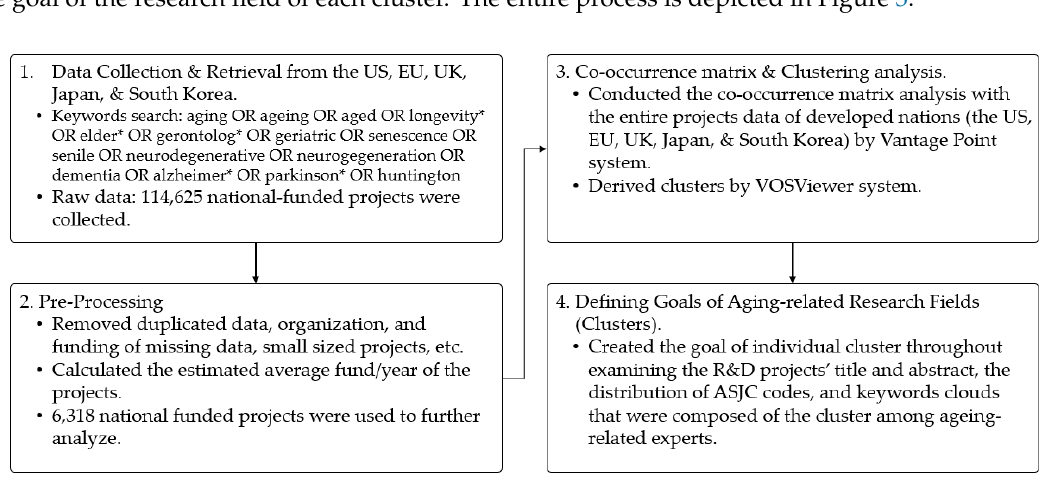
Figure 3. The workflow of data collection and analysis for aging-related national-funded research projects worldwide.